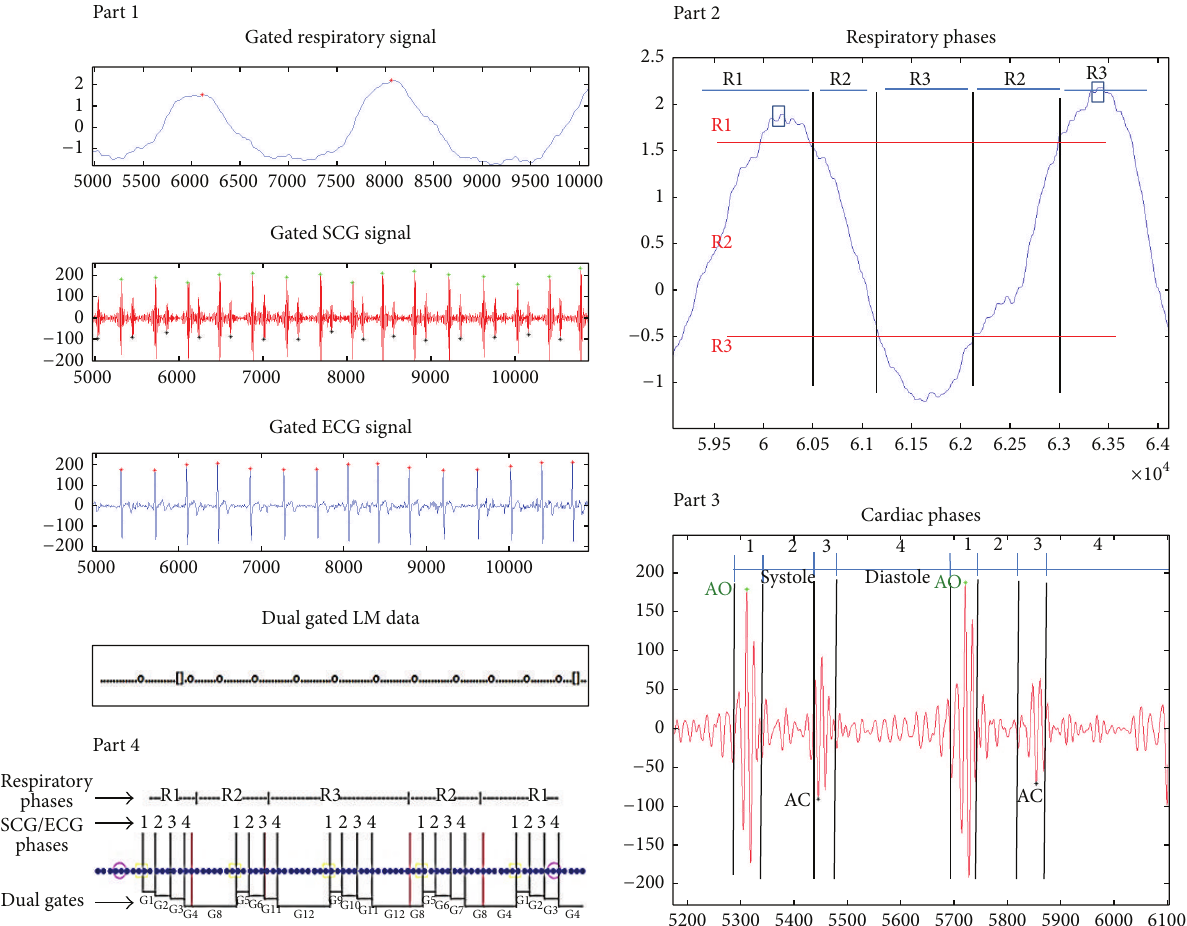
Figure 11: Prospective dual gating diagrams acquired from accelerometer-based method.